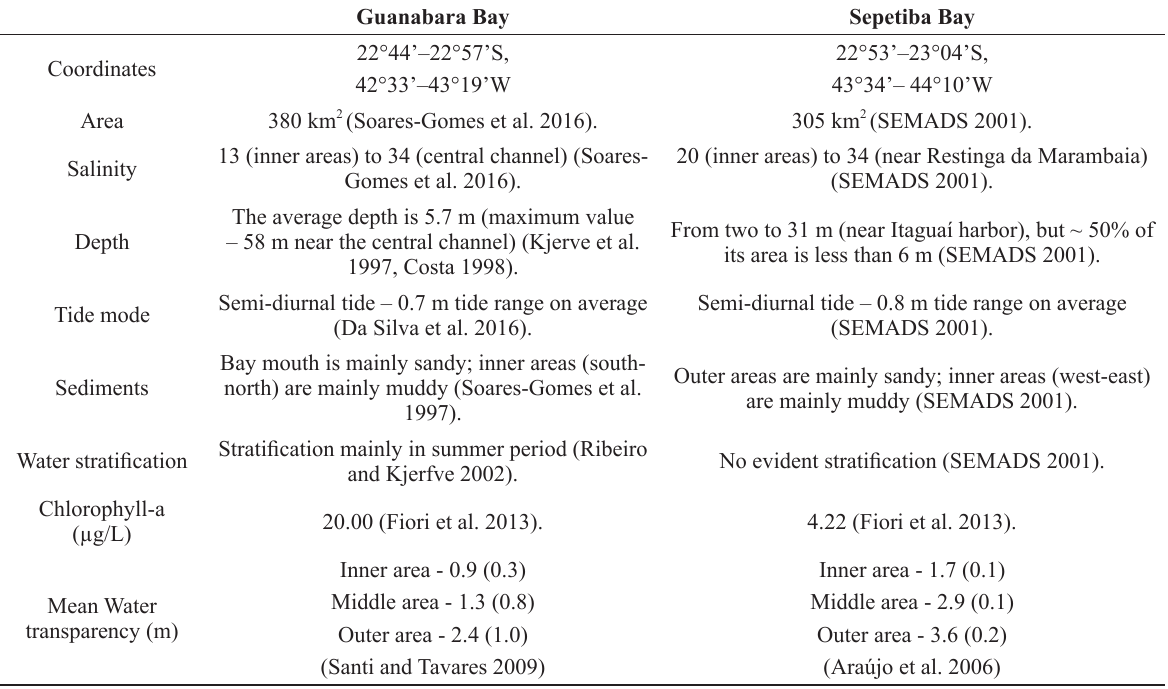
Main physical and hydrological characteristics of Guanabara Bay and Sepetiba